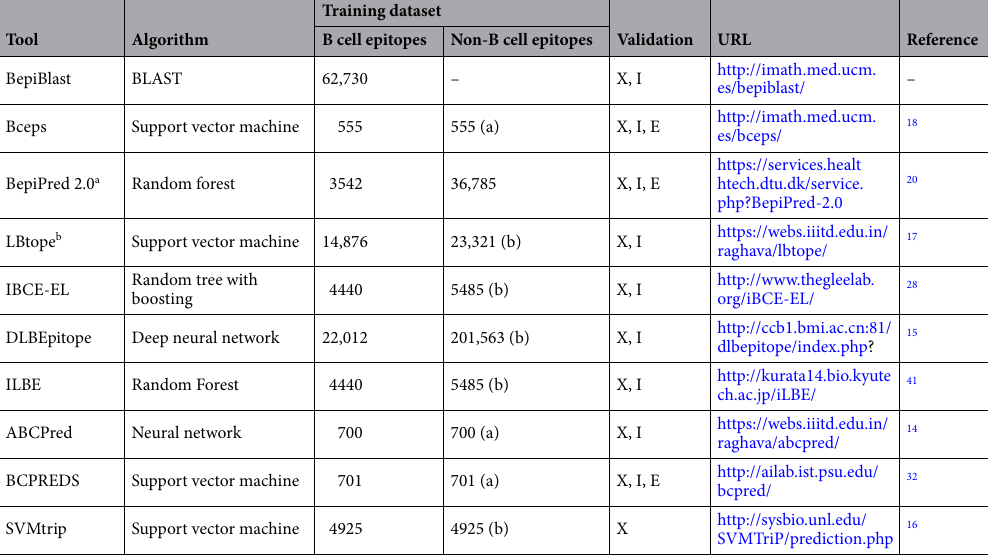
Table 3. Comparison of available web-based tools for predicting linear B cell epitopes. For each tool, table reports the underlying algorithm; the number of B and non-B cell epitopes for model building; the method used for validation (X: cross-validation; I: independent dataset; E: case example); the URL of the tool and the reference. The letter between parenthesis indicates the type of non-B cell epitopes in the training dataset: a, random peptide sequences; b, peptide sequences with reported negative B cell epitope assays. a For BepiPred, B and non-B cell epitope figures correspond to antigen residues that in the tertiary structure of antibody-antigen complexes contact the antibody or not, respectively. b Data for default model in